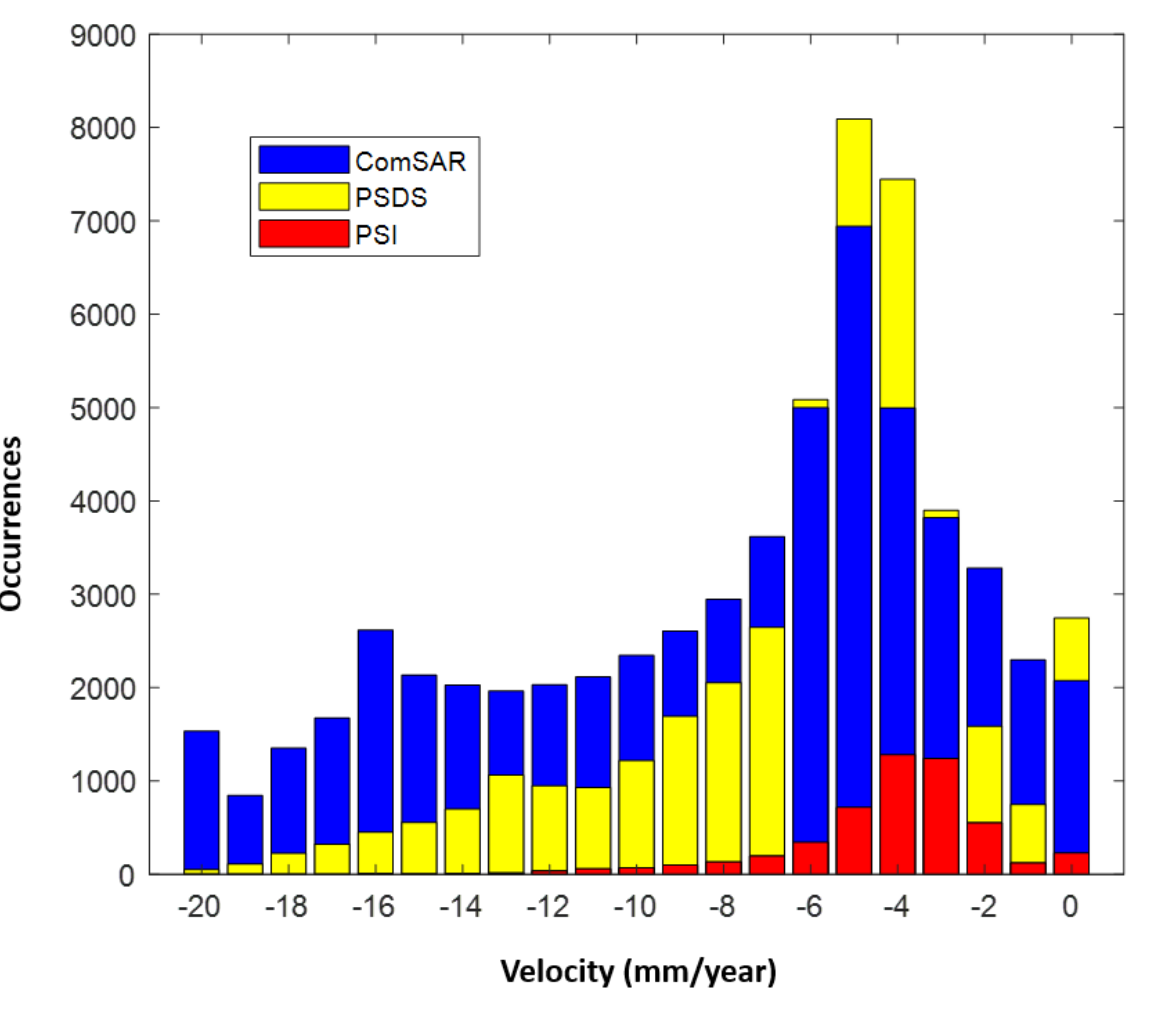
Figure 6. Velocity histogram. The total pixels are 5100, 42,517, and 58,216 points for PSI, PSDS, and ComSAR,